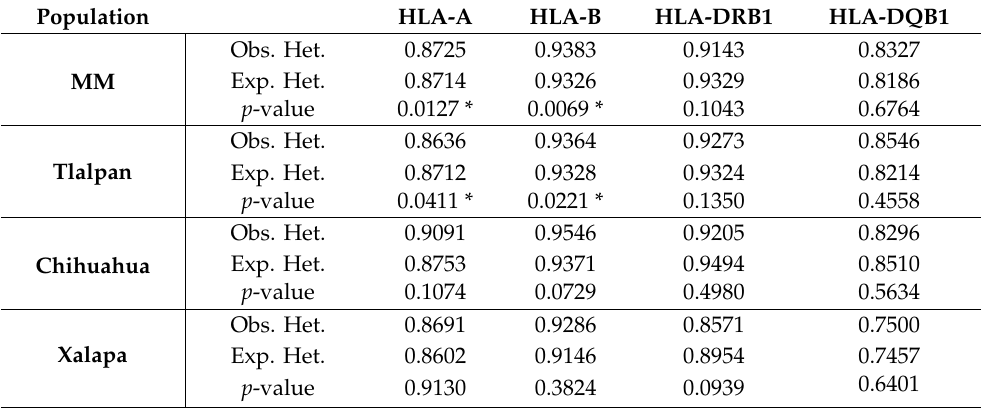
MM: Mexican mestizo, whole population. Obs. Het.: Observed heterozygosity. Exp. Het.: Expected heterozygosity under HWE conditions. The p -value refers to the di ff erence between the observed and expected heterozygosity values. * Only p -values < 0.05 are considered statistically